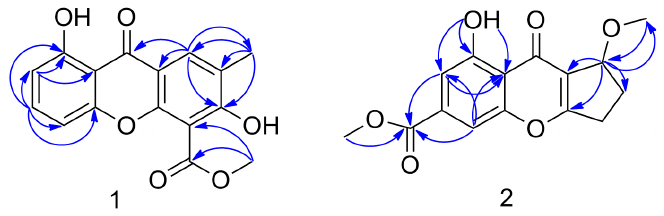
Figure 2. Key HMBC (half arrows) correlations of compounds 1 and 2 .